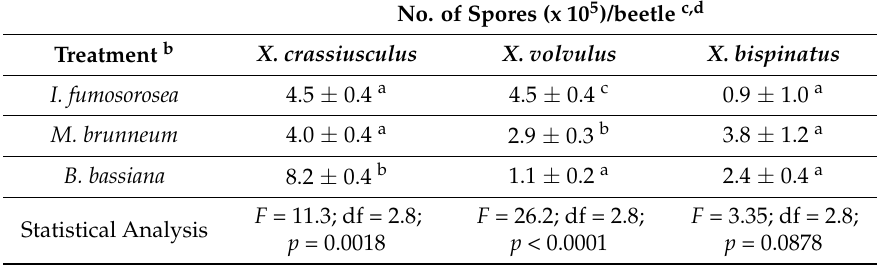
Table 2. Comparison of the acquisition of spores by three ambrosia beetle species after being dipped into three entomopathogenic fungal suspensions a